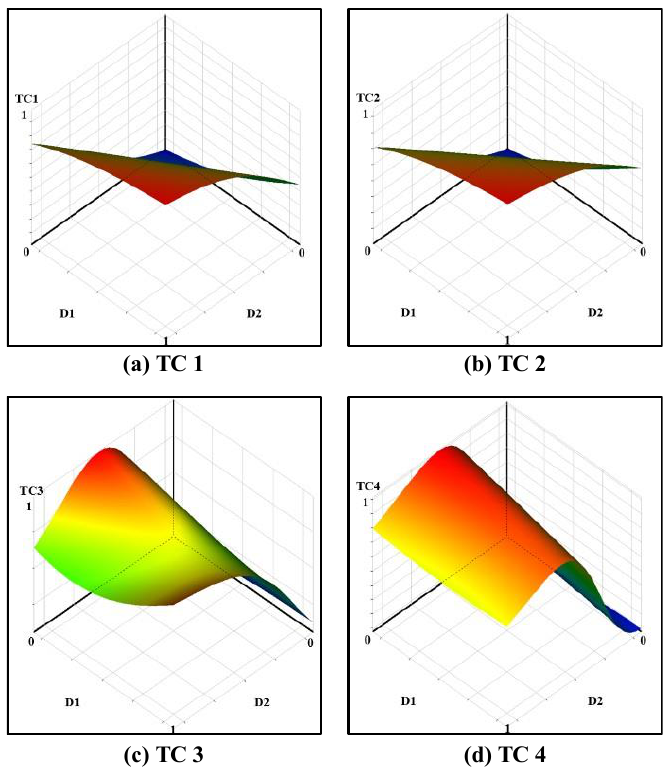
Figure 5. Response surface of neural network method (0 to 1 normalized x, y and z axis).